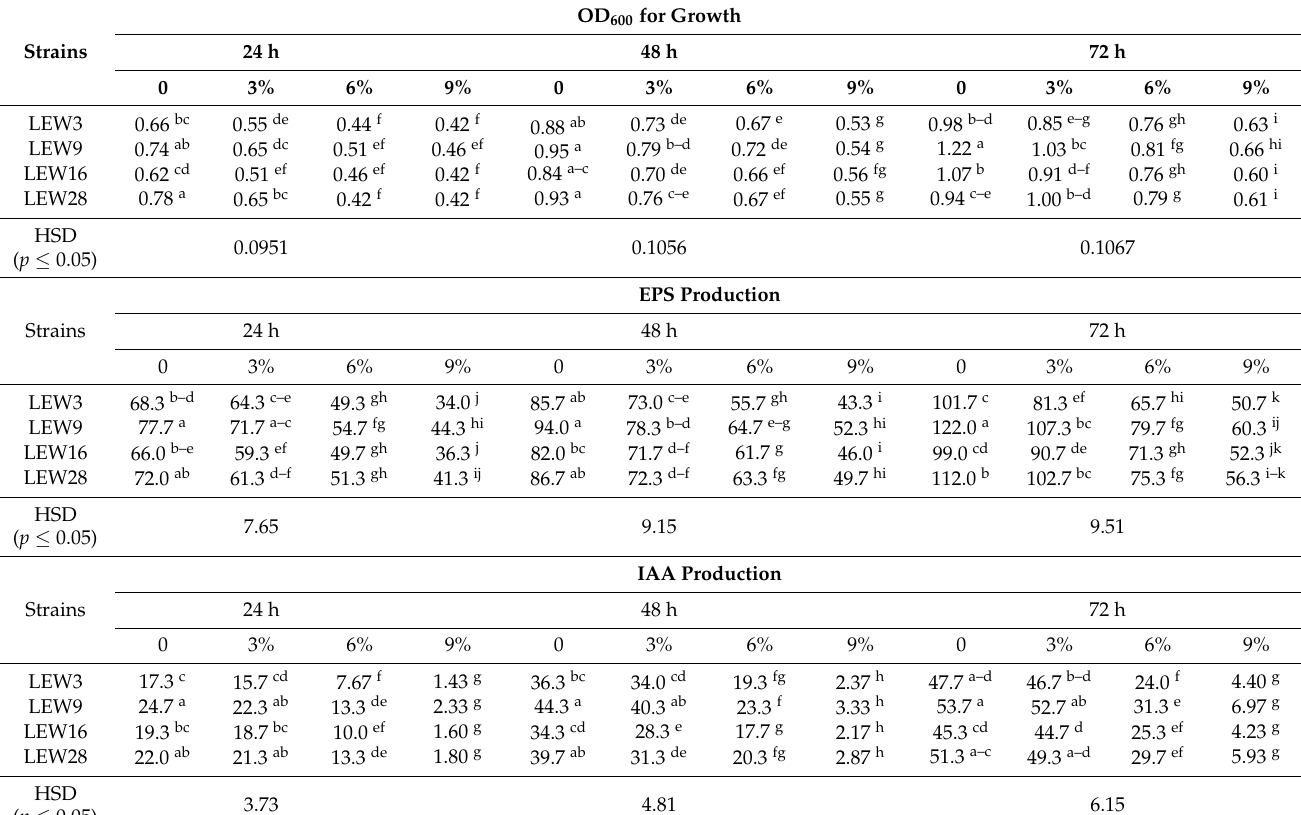
Table 3. Effect of different levels of PEG-6000 on growth, IAA, and EPS production by the rhizobacte- rial